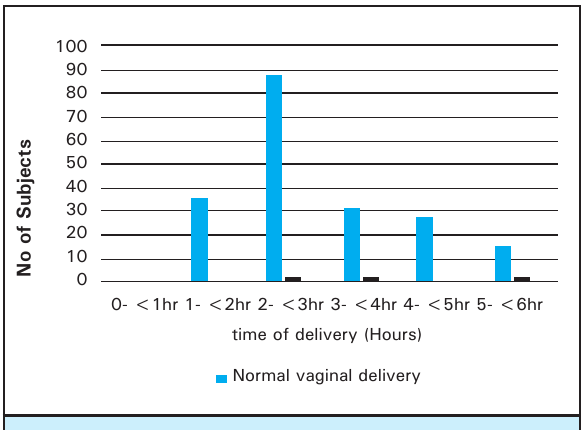
Figure 1. Showing time of deliveries.